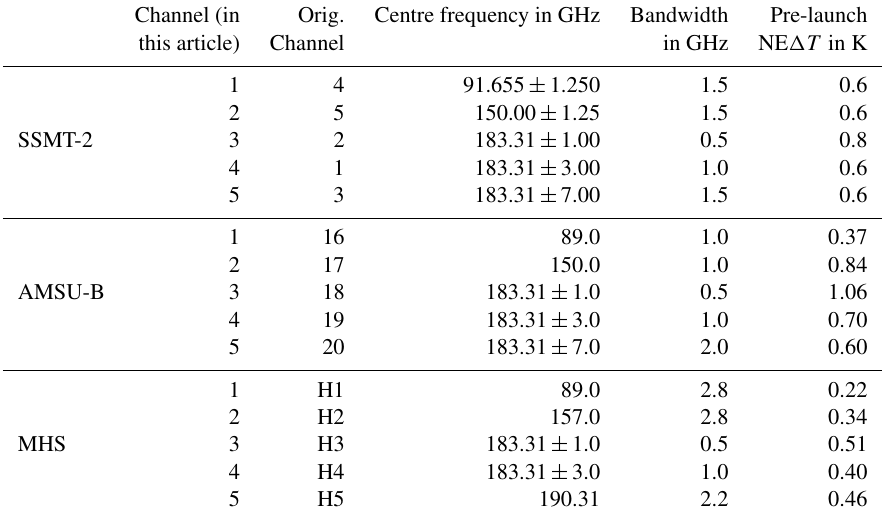
Fig. 1. The drifting as well as the constant orbits of the Metop satellites are clearly